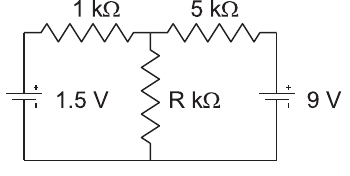
FIG. 9. Circuit for sample problem 2.